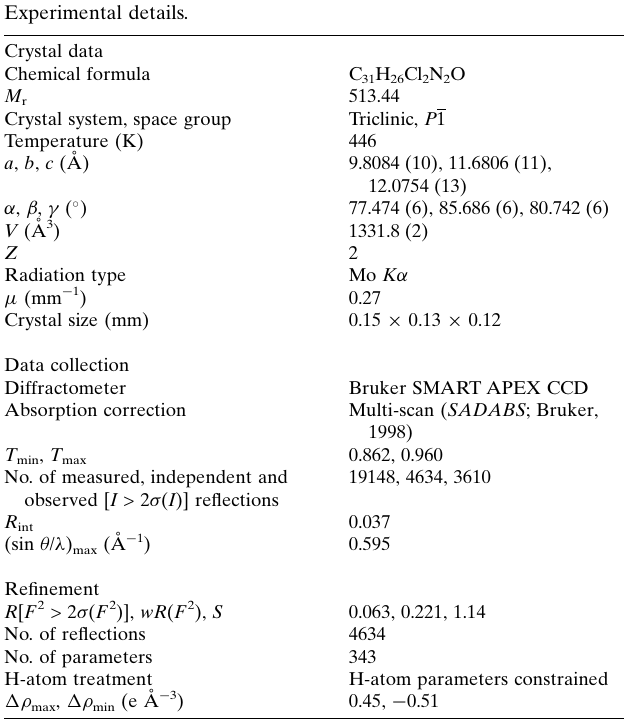
Table 2 Experimental details.